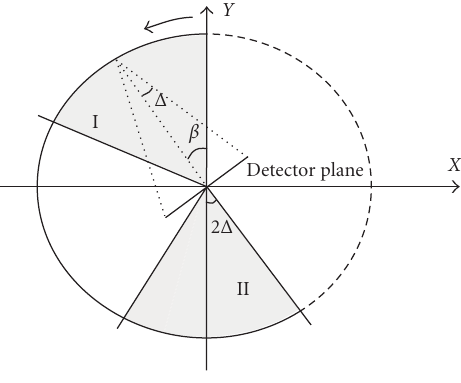
Figure 2: Illustration of redundant region in terms of projection angle in circular fan beam half